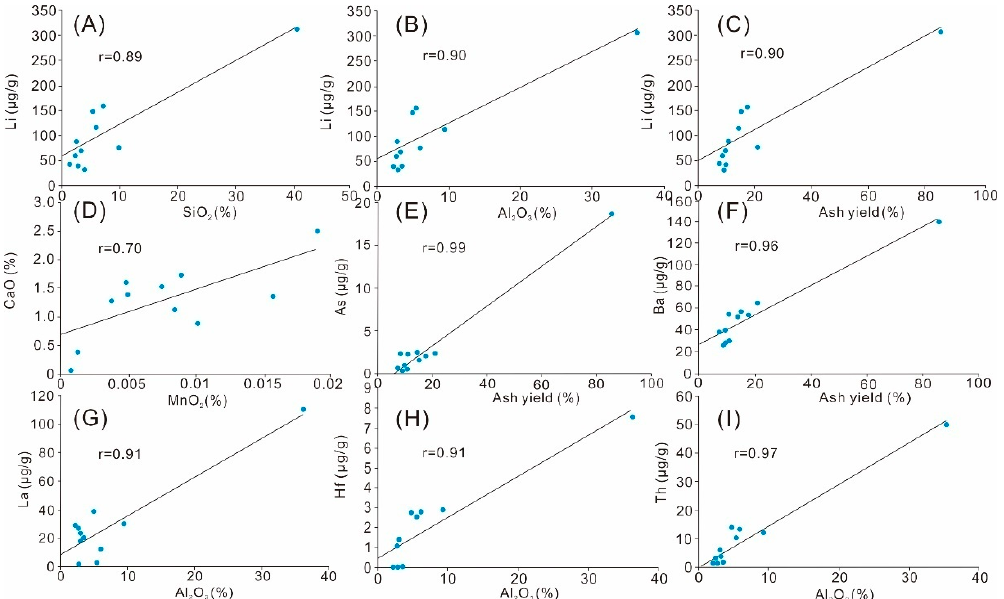
Figure 7. Correlations between selective element concentrations or with high-temperature ash(HTA) yield in the No. 11 coal (on a whole-coal basis). ( A – C ). Correlations of Li concentration with SiO 2 , Al 2 O 3 content and HTA yield; ( D ) Correlations between CaO and MnO 2 content; ( E–F ) Correlations of As and Ba concentration with sulfur content; ( G–I ) Correlations of La, Hf, and Th concentration with Al 2 O 3 content.